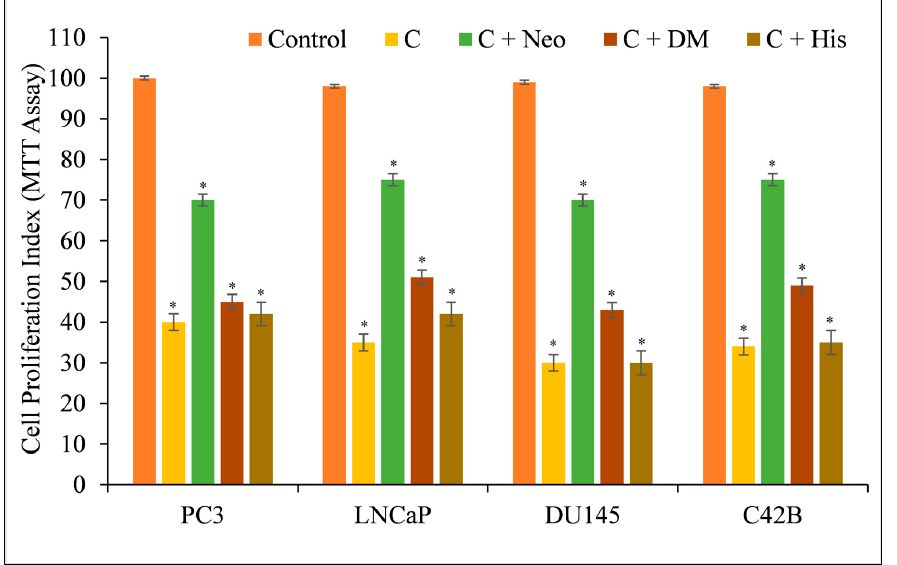
Figure 5. The effects of metal ‐ specific chelators on the antiproliferative activity of curcumin in four distinct prostate cancer cell lines. Cancer cells were treated with 25 μ M of curcumin alone or in the presence of copper chelator neocuproine (Neo), iron chelator desferrioxamine mesylate (DM), or zinc chelator histidine (His), as shown in the figure. The metal chelator concentration utilized was 50 μ M. After 72 h of treatment, the MTT assay specified in Section 2 was conducted. The values presented are the ±S.E.M. of three separate experiments. * p value < 0.05 when compared to the control group.